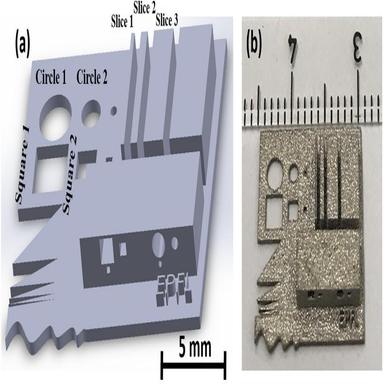
(a) CAD file of a benchmark with complicated features, and (b) the benchmark fabricated from the Zr-based BMG via LPBF.